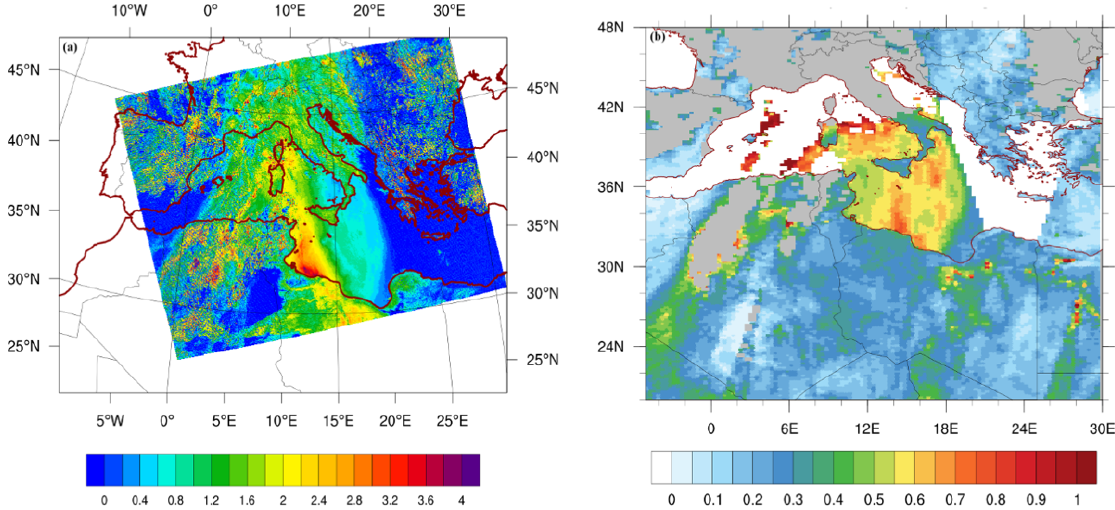
Figure 3. ( a ) Thermal emissive dust index (TEDI) from the VIIRS NOAA-20 brightness temperature; ( b ) MODIS/MAIAC aerosol optical depth for 20 June 2021. ( b ) MODIS/MAIAC aerosol optical depth for 20 June